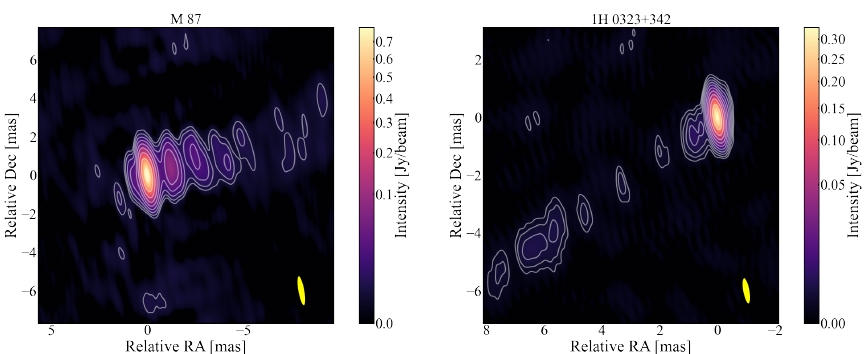
Figure 5. Natural weighted images obtained from EATING VLBI: ( left ) M87 image. ( right ) 1H 0323+342 image. For each image, contours start from 1, 2, 4 ...times a 3 σ image rms level and increase by factors of 2, and the color bar shows the intensity. The yellow ellipse in the bottom is the beam size of the each map. Image parameters are reported in Table 5.